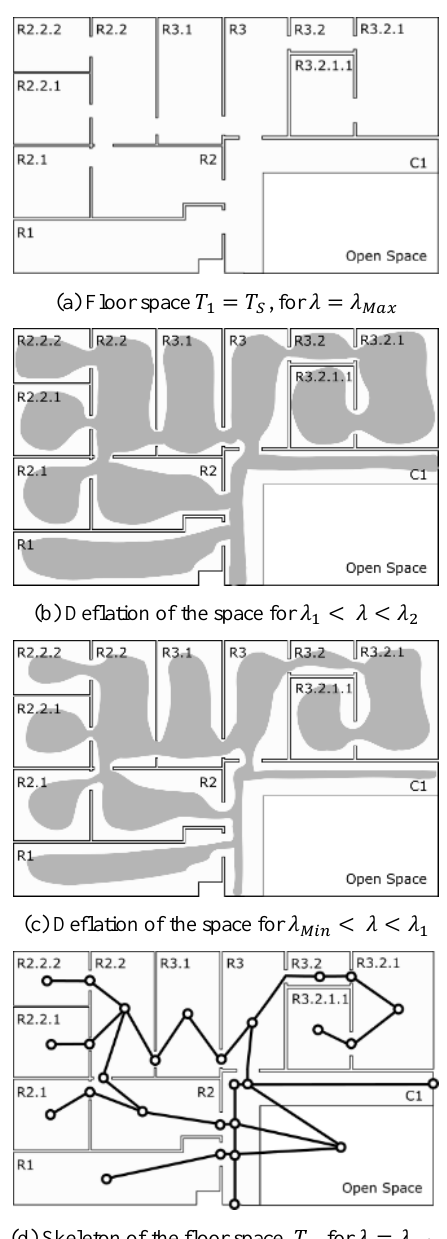
Figure 1. The concept of space deflation. The space is gradually deflated onto a